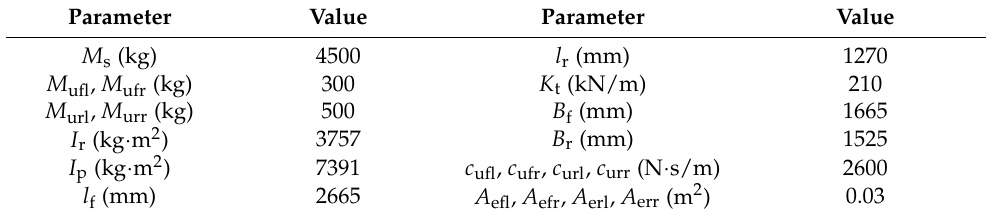
Table 1. Parameters of the vehicle model.